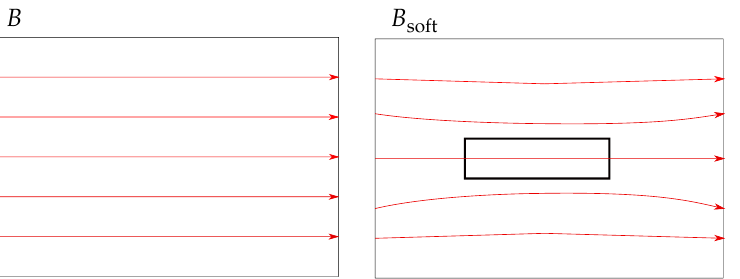
Figure 2. Comparison of the magnetic flux density B for undistorted ( left ) and soft-iron distorted ( right ). A ferromagnetic material (black rectangle) is placed within B .